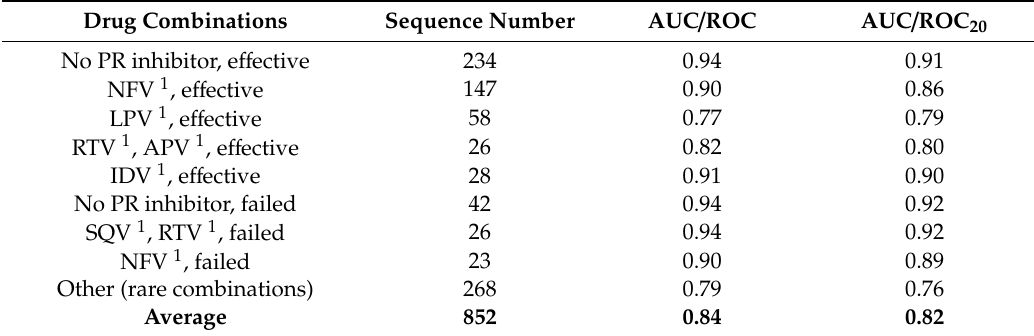
Table 2. Prediction results of immunological e ff ectiveness / failure of treatment for HIV-1 protease inhibitors obtained using the random forest classifier based on the features of nucleotide sequences of a particular viral variant and clinical parameters (CD4 + cells and the number of viral RNA